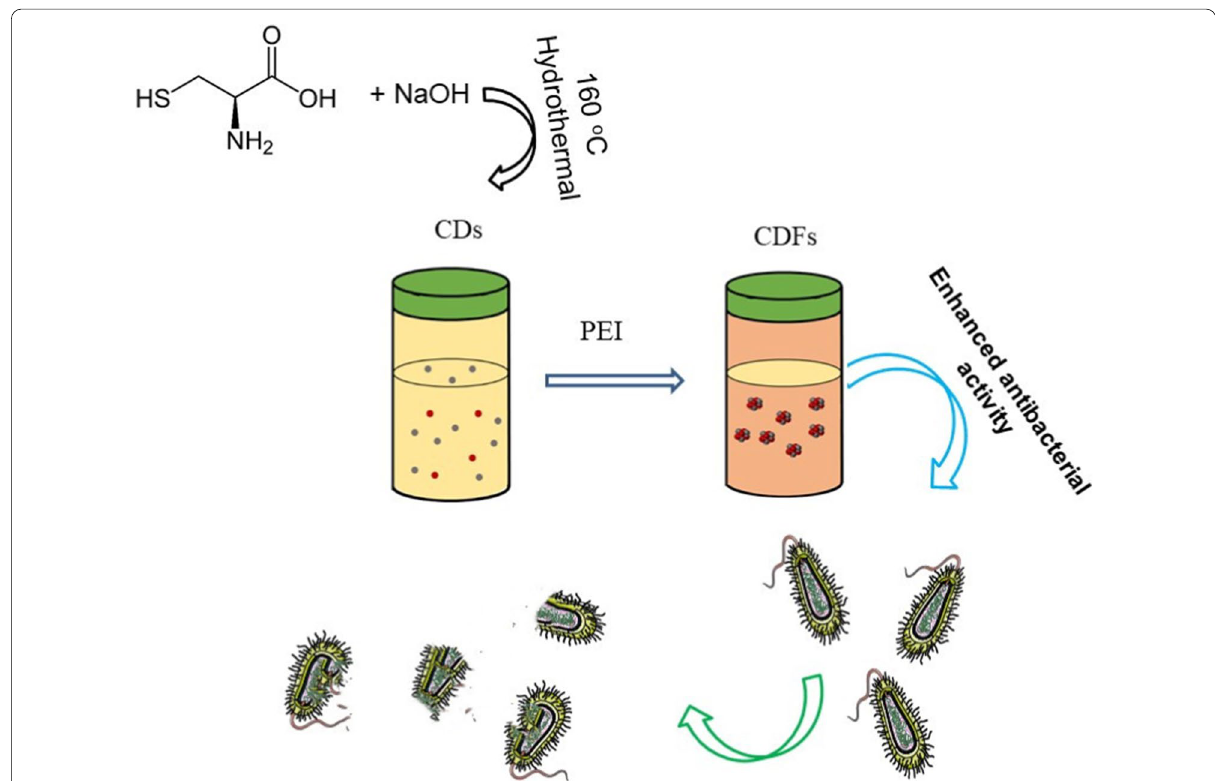
Fig. 1 Scheme for the synthesis of CDs and the assembly into CDFs by adding PEI with enhanced antibacterial